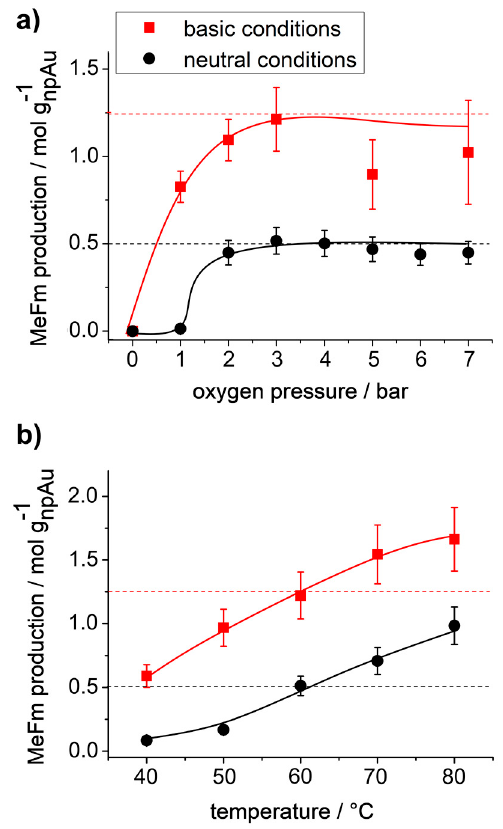
Figure 4. ( a ) MeFm production as a function of oxygen pressure at 60 °C and ( b ) of temperature at 3 bar O 2 . The catalytic experiments were performed under basic conditions (12 mM MOH in methanol) and neutral conditions over npAu containing less than 1 at% Ag residues for 24 h.